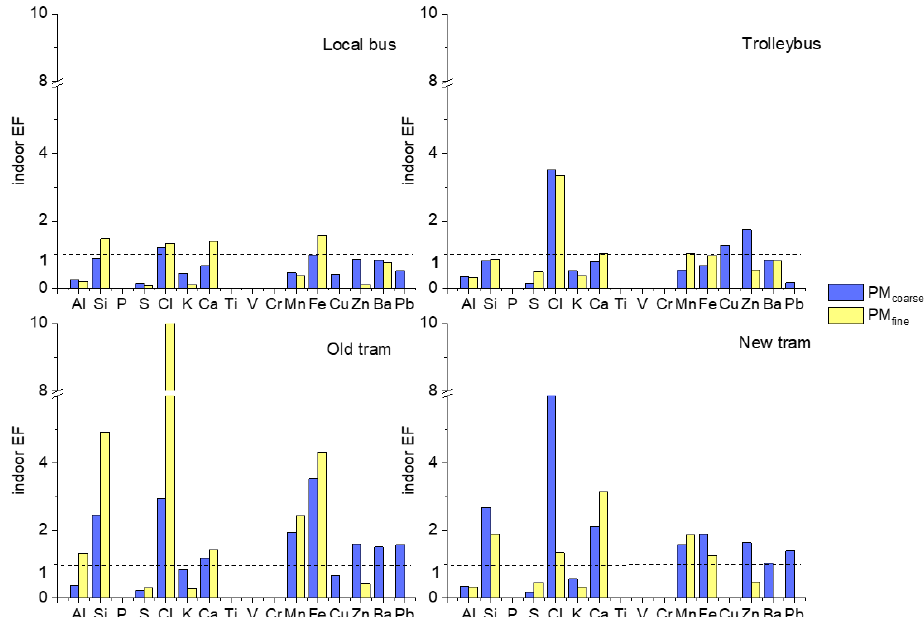
Figure 2. Indoor EF ratios in different vehicles in PM fine and PM coarse fractions in 2014.